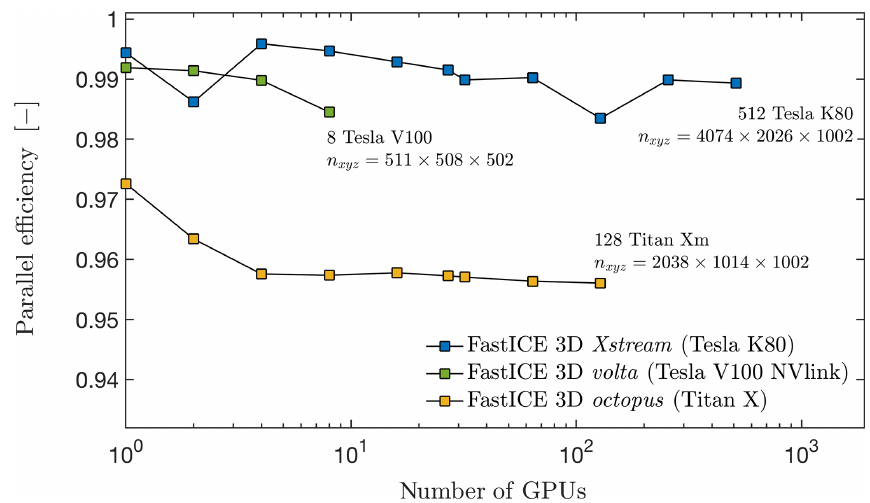
Figure 19. MPI weak scaling of the 3-D thermomechanically coupled GPU-based FastICE software. We report the parallel efficiency (–) of the numerical application on three different Nvidia hardware accelerators, the 1-512 Tesla K80 12GB data-centre GPUs, the 1-8 Tesla V100 32GB Nvlink data-centre GPUs and the 1-128 Titan X (Maxwell) 12GB consumer electronics GPUs. These accelerators are available via the Xstream supercomputer, the Volta node and the octopus supercomputer, respectively. Note that the execution time baseline used to compute the parallel efficiency represents a non-MPI calculation. We report the highest numerical grid resolution n xyz achieved on each distributed memory